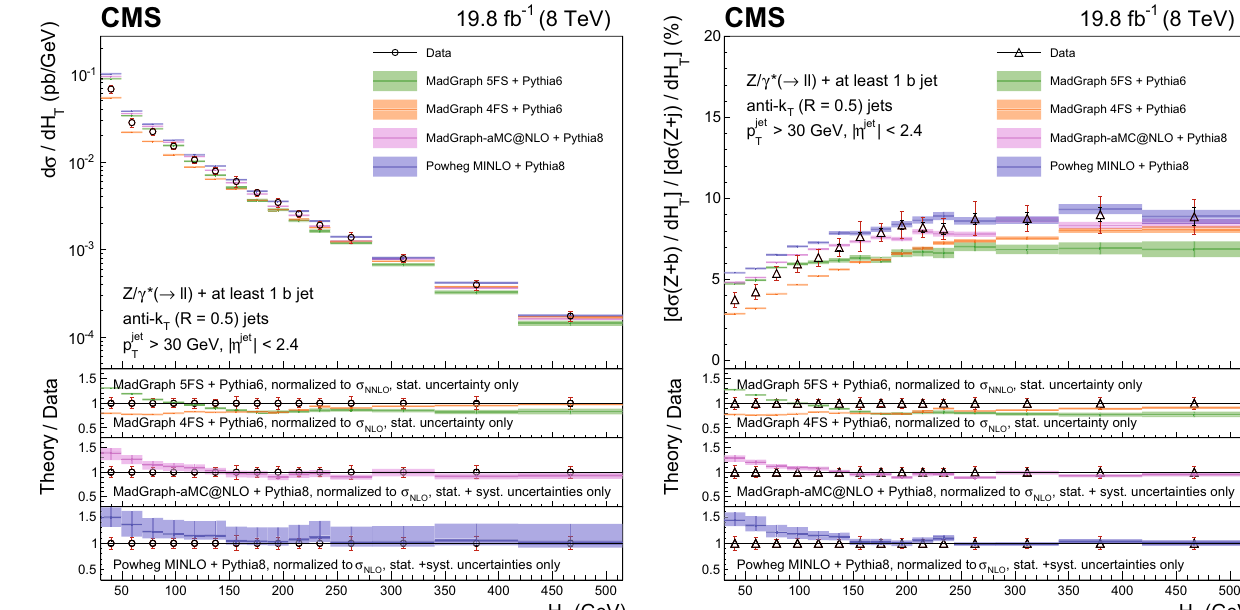
data point the statistical and the total (sum in quadrature of statistical and systematic) uncertainties are represented by the double error bar . The width of the shaded bands represents the uncertainty in the the- oretical predictions, and, for NLO calculations, theoretical systematic uncertainties are added in the ratio plots with the inner darker area representing the statistical component only